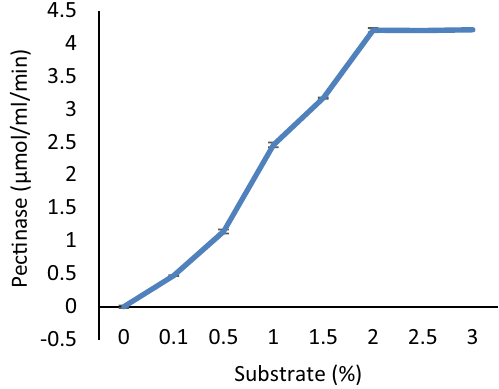
Figure 4. Effect of substrate-level on pectinase activity.